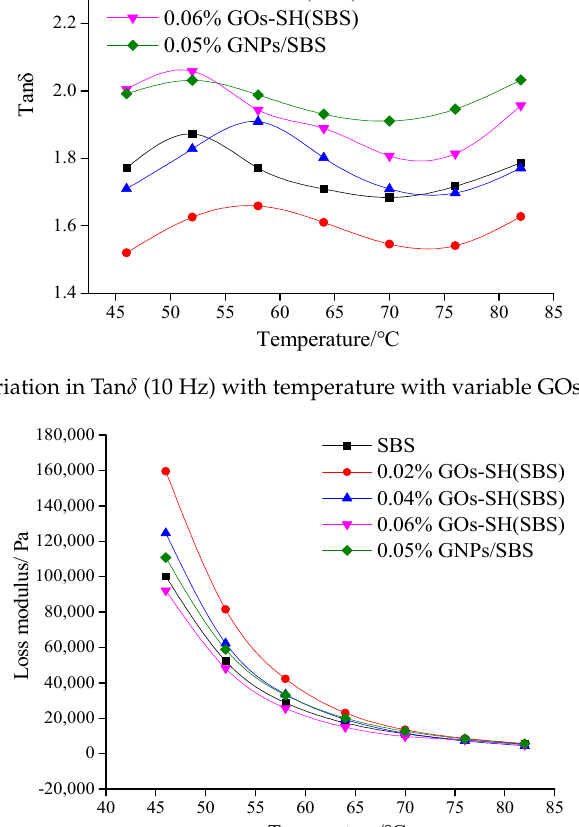
Figure 7. Variation in loss modulus G ′′ (10 Hz) with temperature at variable GOs-SH content.